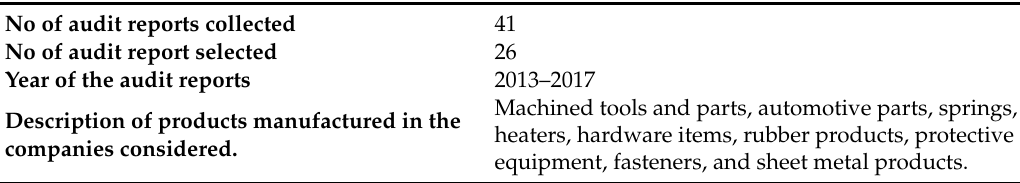
Table 1. Details of audit reports in the case